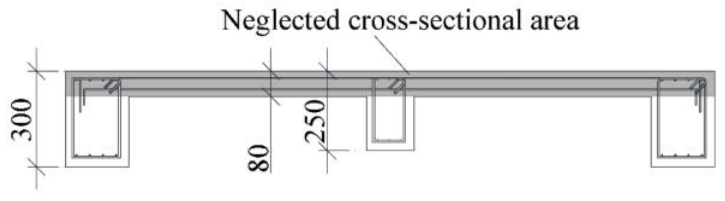
Figure 17. The cross section after drying considered in the